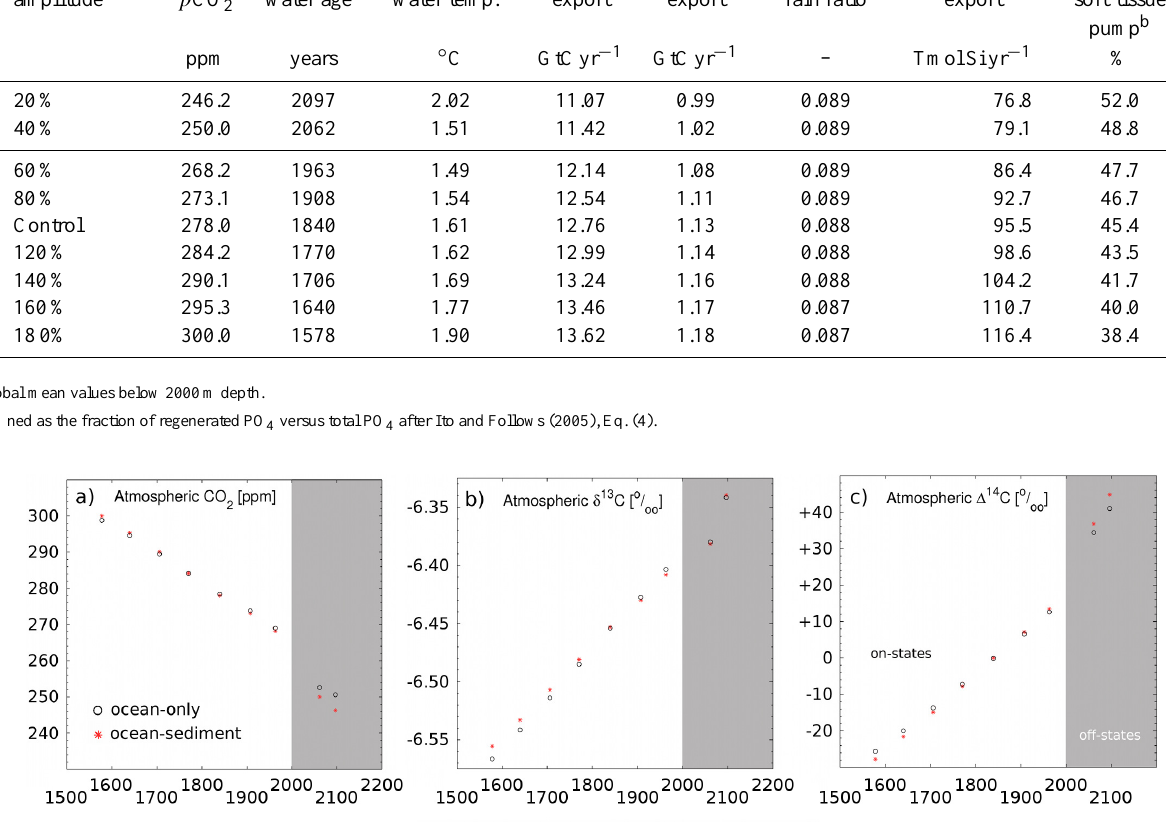
Table 2. Ocean ventilation experiments in the ocean-sediment model: simulated changes in the global mean deep ocean temperature, biological production and in the effeciency of the soft-tissue pump at the time slice 2kyr after the abrupt variation in ocean ventilation. SO wind stress Atm. Mean deep Mean deep POM CaCO 3 Global mean Opal Efficiency of amplitude p CO 2 water age a water temp. a export export rain ratio export soft-tissue ppm years GtCyr − 1 GtCyr − 1